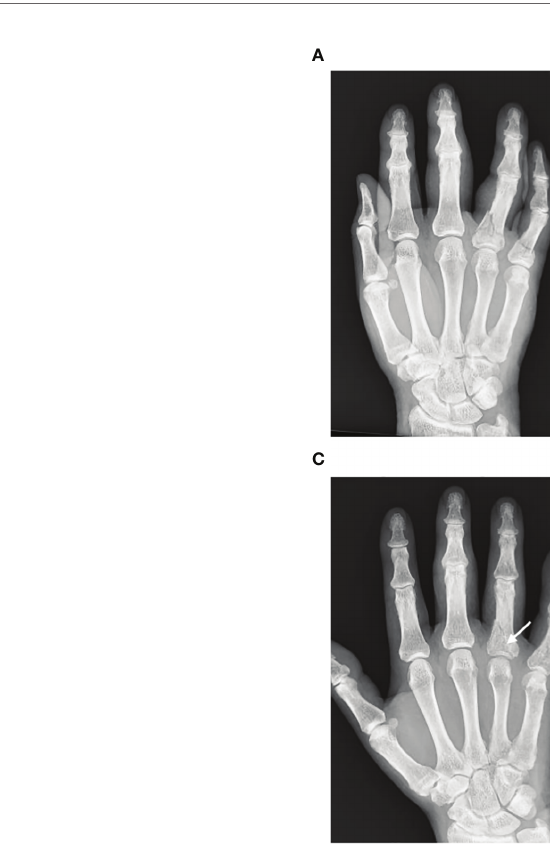
TABLE 1 | Relevant information regarding immunological mechanism of CRPS.